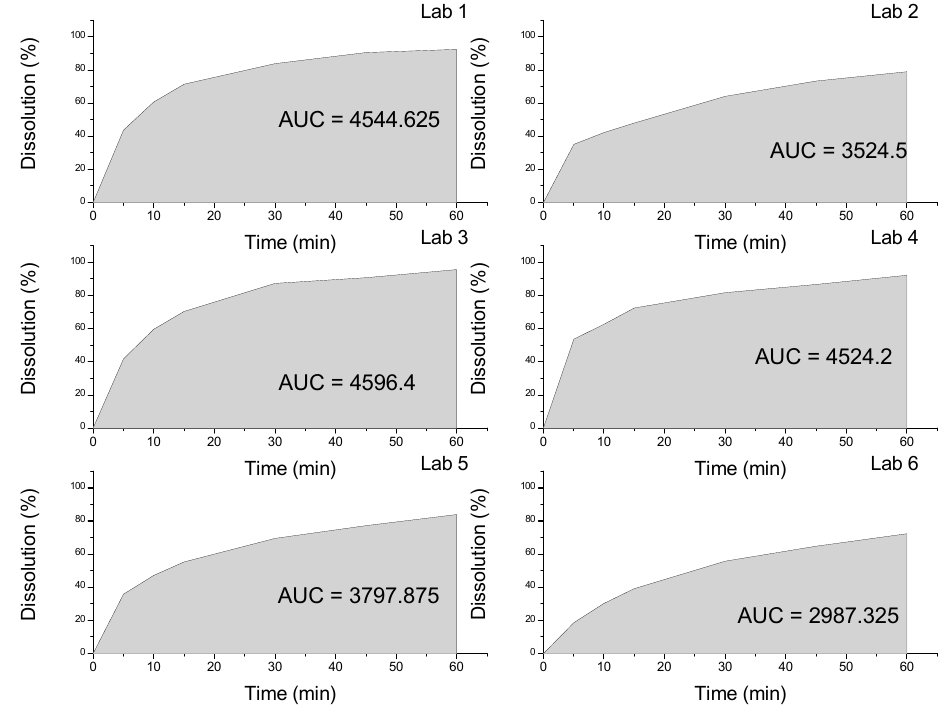
Figure 2. Dissolution profile of the six laboratories evaluated for determination of the